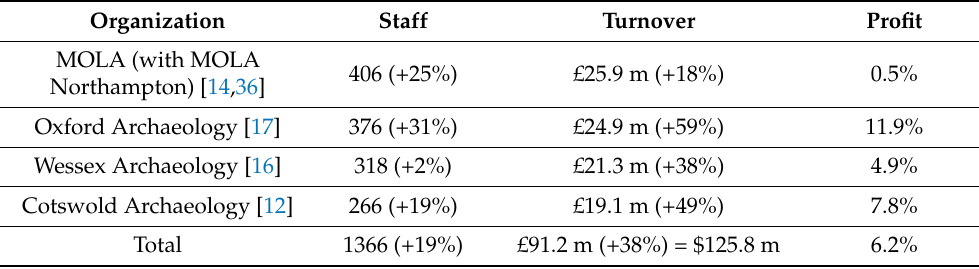
Table 4. 2020–2021 financial figures for four archaeological